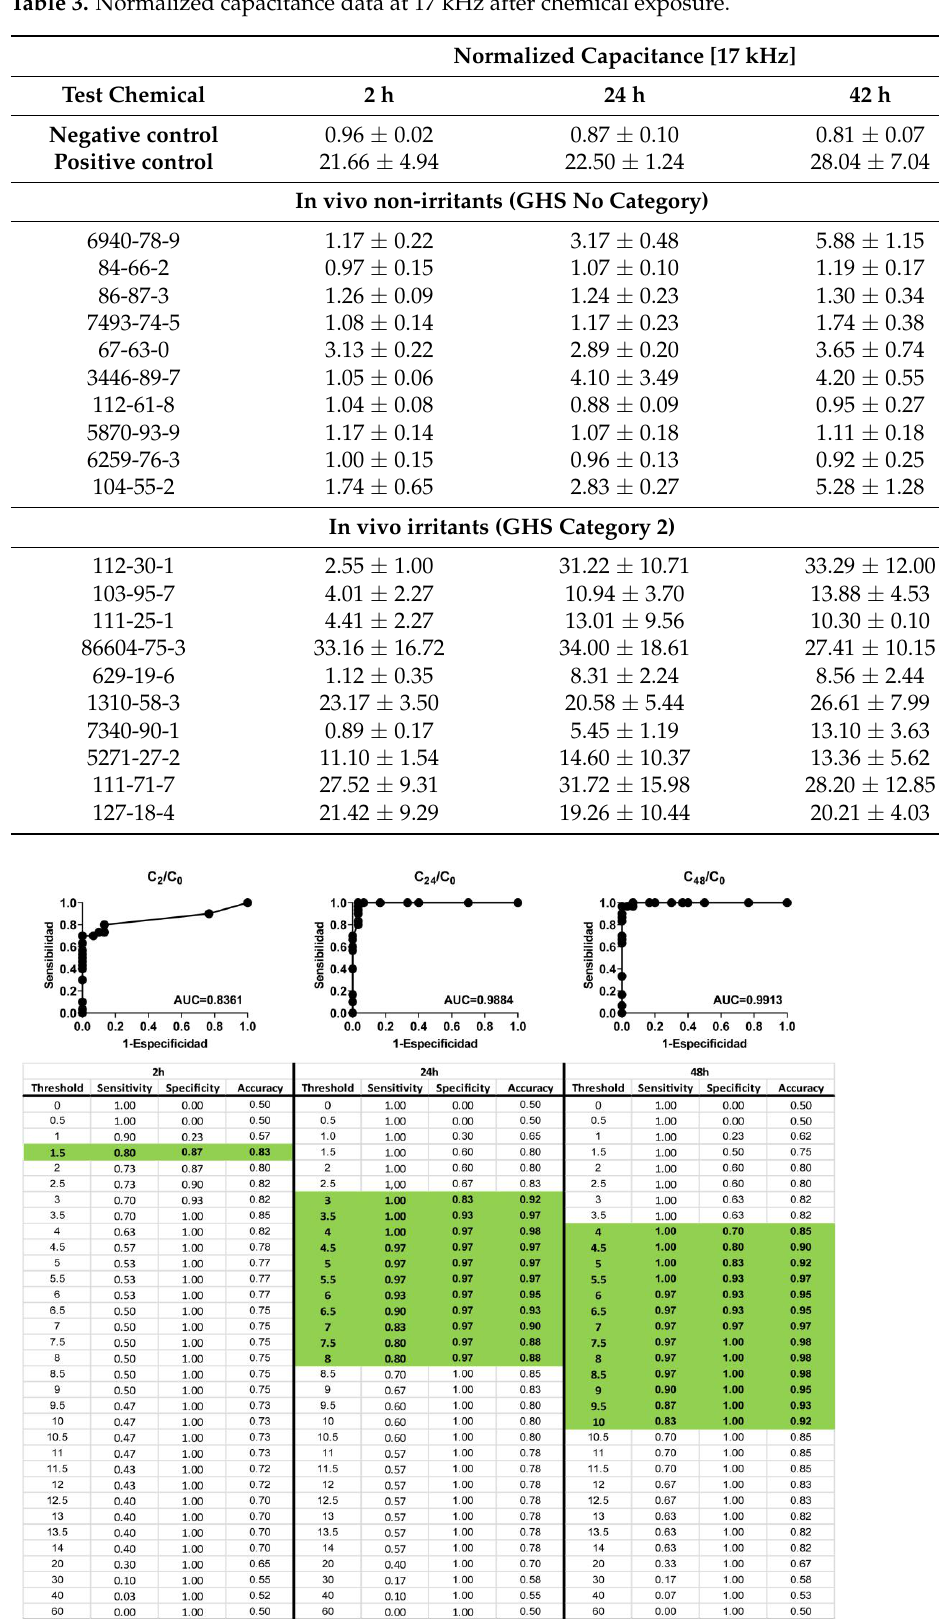
Figure 6. ROC curve analysis for 20 reference chemicals. Highlighted fields represent the cut-off values complying with OECD TG 439 requirements.